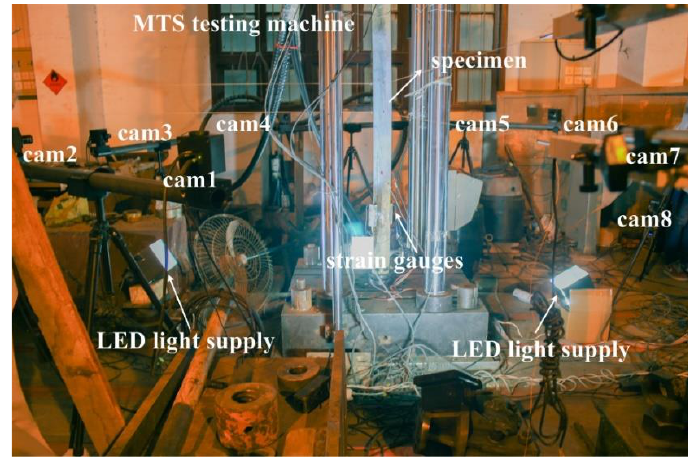
Figure 16. Experimental setup for the axial compression experiment of timber column.